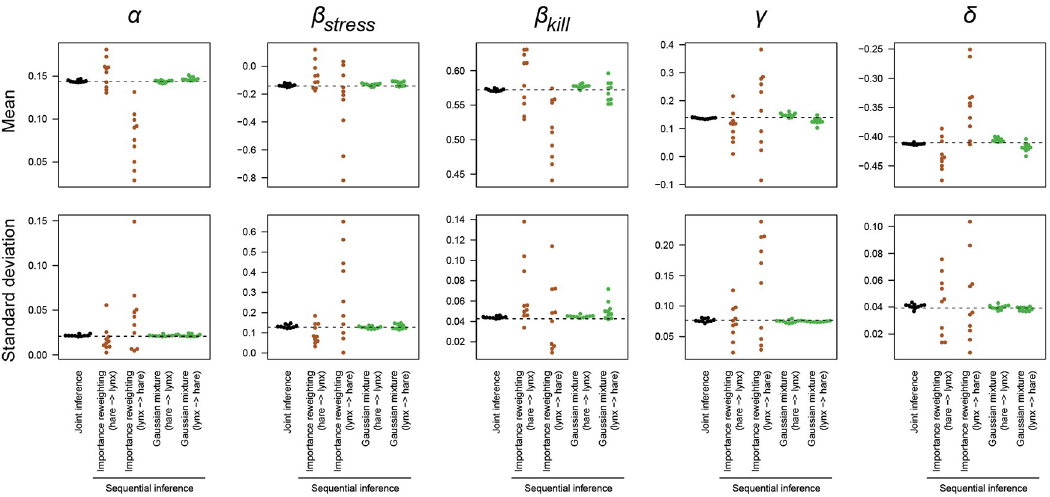
Fig 8. Accuracy of joint versus sequential inference. Each point represents the mean and standard deviation of the marginal posterior distribution from one run. Each run has the same total number of model evaluations (1.8 million). The dashed line indicates the mean and standard deviation of the posterior from a joint inference run with 100-fold more model evaluations.